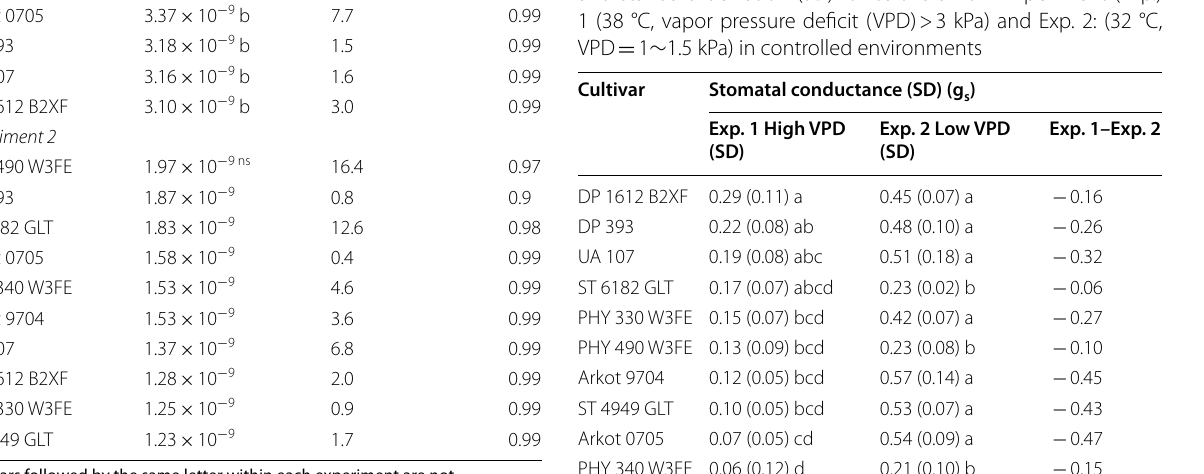
, mol (H O) m − 2 s − 1 ) ratios s 2 · ·